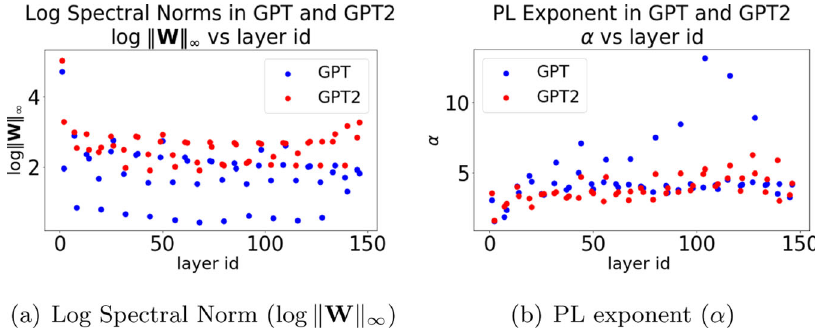
Fig. 7 Log Spectral Norms and PL exponents for NLP models. Log Spectral Norms (in ( a )) and PL exponents (in ( b )) for weight matrices from the OpenAI GPT and GPT2-small pretrained models. (Note that the quantities shown on each Y axis are different). In the text, this is interpreted in terms of Scale Collapse and Correlation Flow.